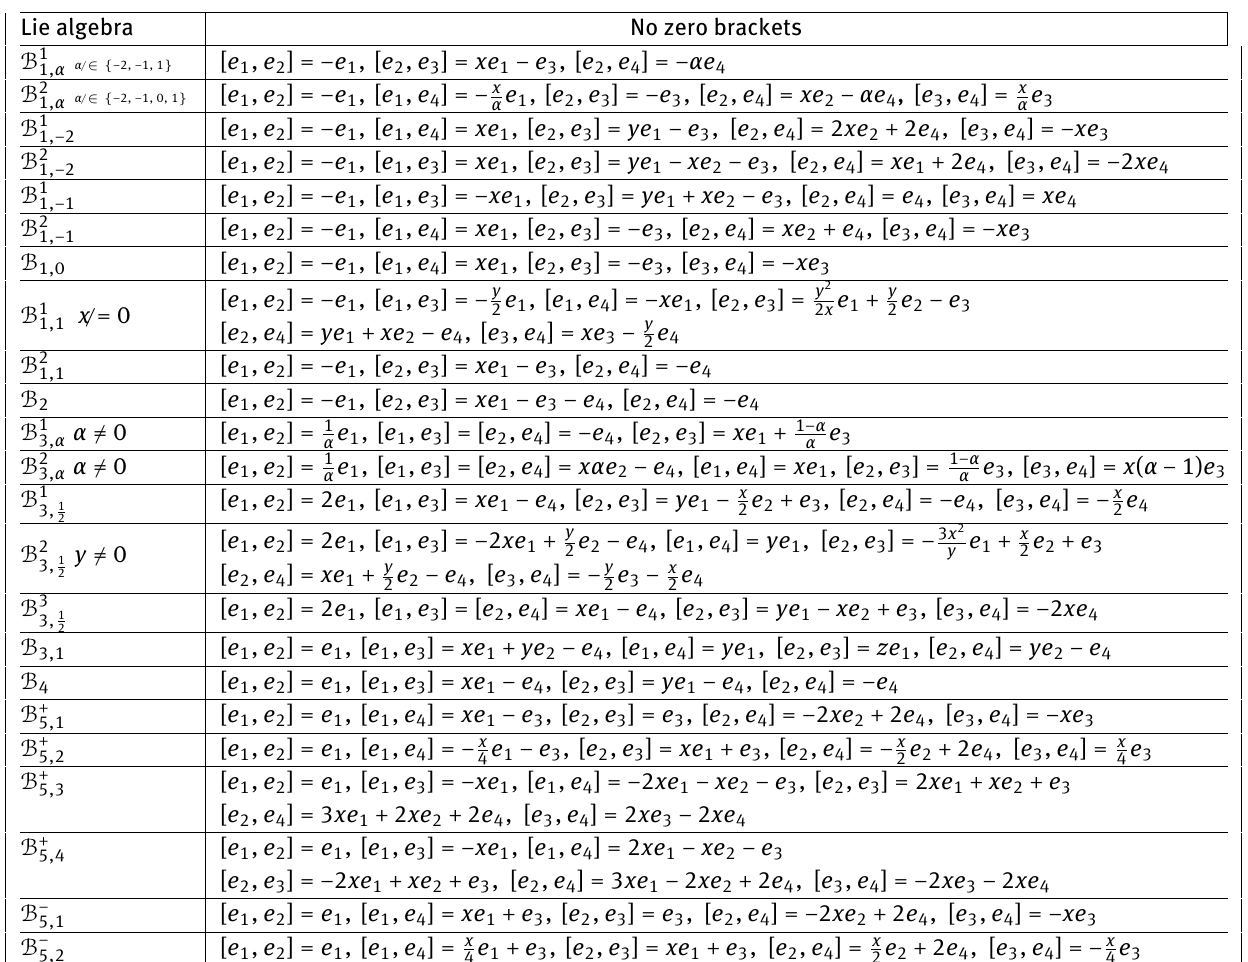
Table 4: Four-dimensional Para-Kähler Lie algebras coming from b Lie algebra No zero brackets B 1 1, α α ̸ ∈ { −2,−1,1